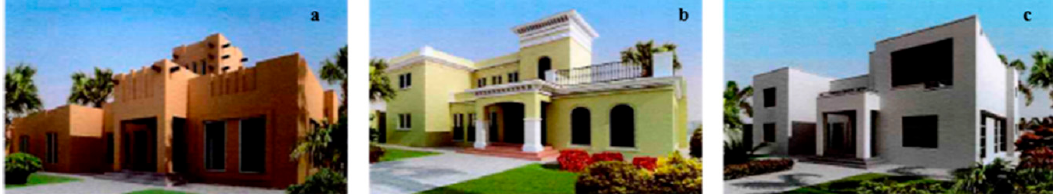
Figure 5. Single-family house types within Al Falah community in Abu Dhabi, ( a ) Three bedroom villa, heritage style; ( b ) Four bedroom villa, Andalusian style; ( c ) Five bedroom villa, modern style (Source: